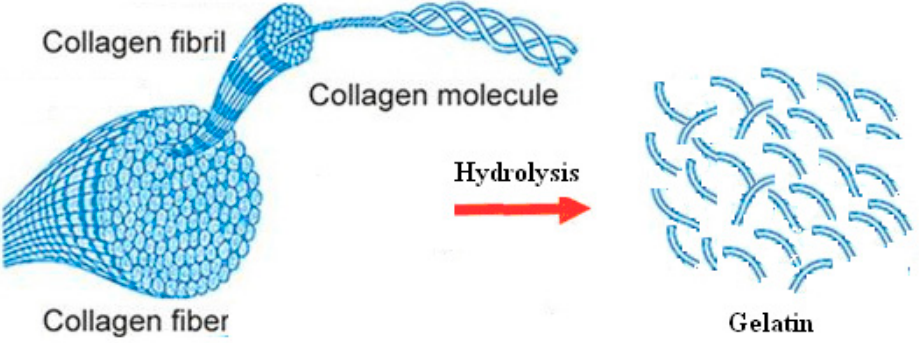
Figure 14. Schematic representation of the production of gelatin from collagen.